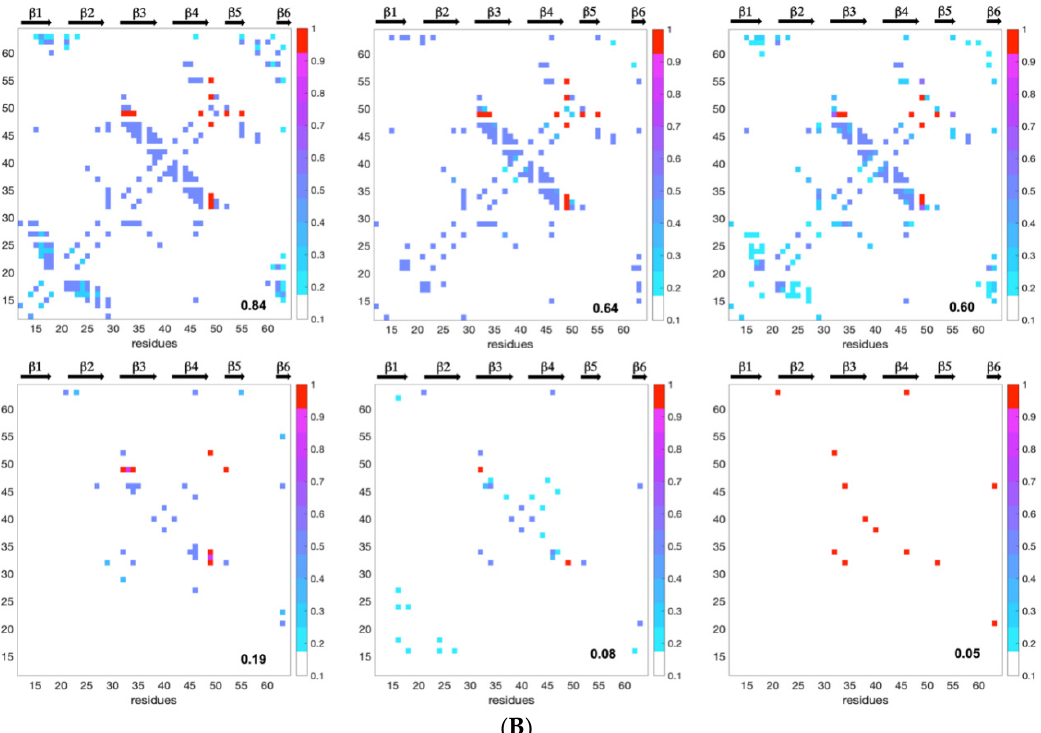
Figure 8. Fractional contact map evolution upon pressure unfolding reaction ( A ) for AVR-Pia and ( B ) for AVR-Pib. The Q values are given on the lower right corner of each contact map. The probability to find a contact is shown by a dot colored from red (probability of 1) to light blue colors (minimum probability of 0.2). The black dot for AVR-Pia corresponds to the C25-C66 di-SS bond. Black arrows at the top of each panel show strand secondary structures. Horizontal red arrows highlight contacts involving C25, and green vertical arrows indicate contacts in inter-strands turn regions found in AVR-Pia.